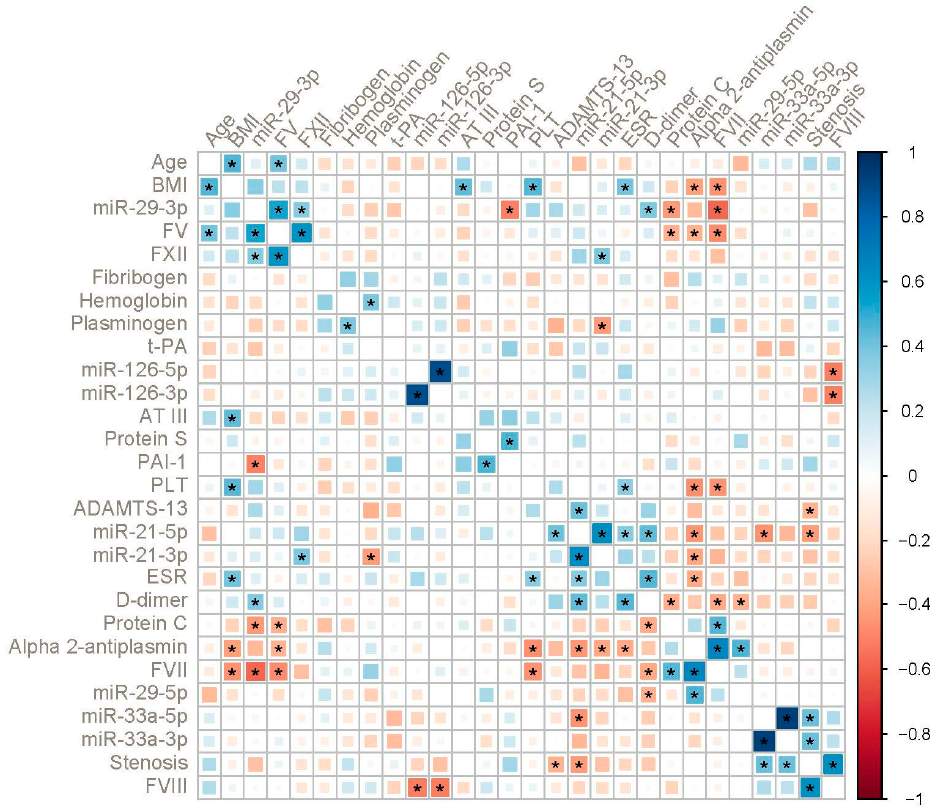
Figure 3. Correlogram in patients with mild-to-moderate CA with hierarchical clustering. The color indicates the direction and strength of correlation (Spearman’s ρ ). Asterisks indicate statistically significant correlations ( p < 0.05).